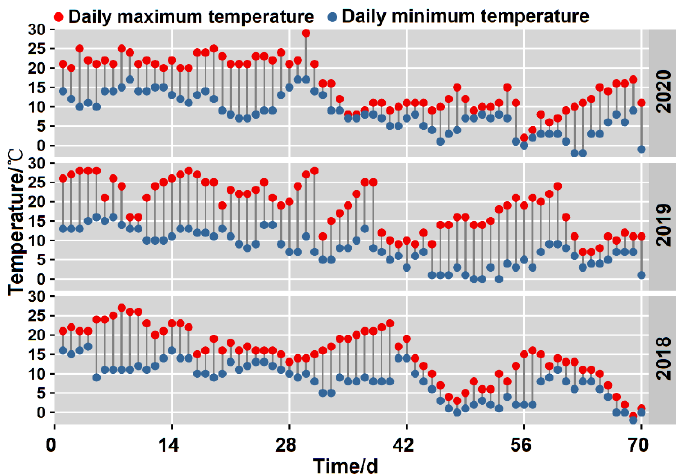
Figure 1. The daily mean temperature of sampling period in Fengxin